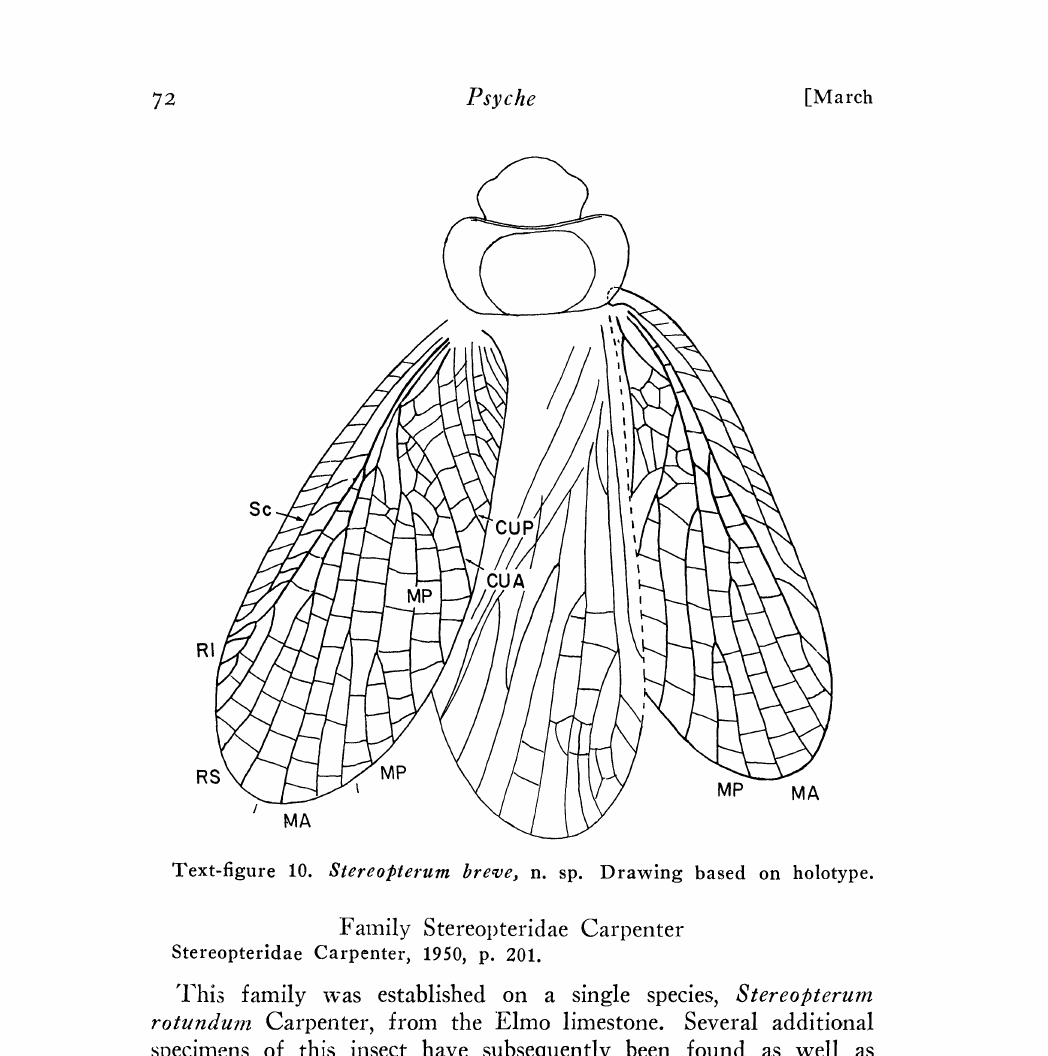
MA Text-figure 10. Stereotterum breoe, n. sp. Drawing based on holotype. Family Stereopteridae Carpenter Stereopteridae Carpenter, 1950, p.